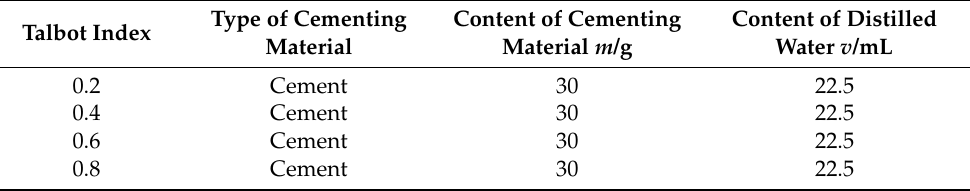
Table 3. Experimental program for the production of the cemented rockfill specimen.